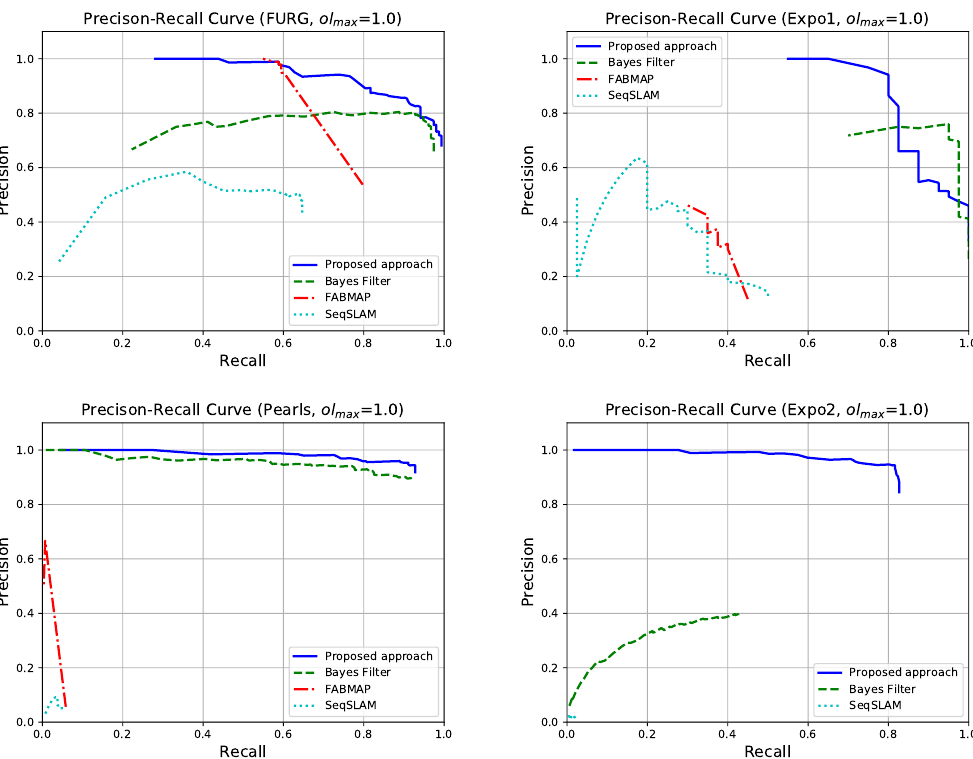
Figure 9. Precision-Recall curves obtained with ol max = 1.0. This means that all the images in each dataset are utilized. A method is not shown in a plot when it was not able to recognize previously seen places.